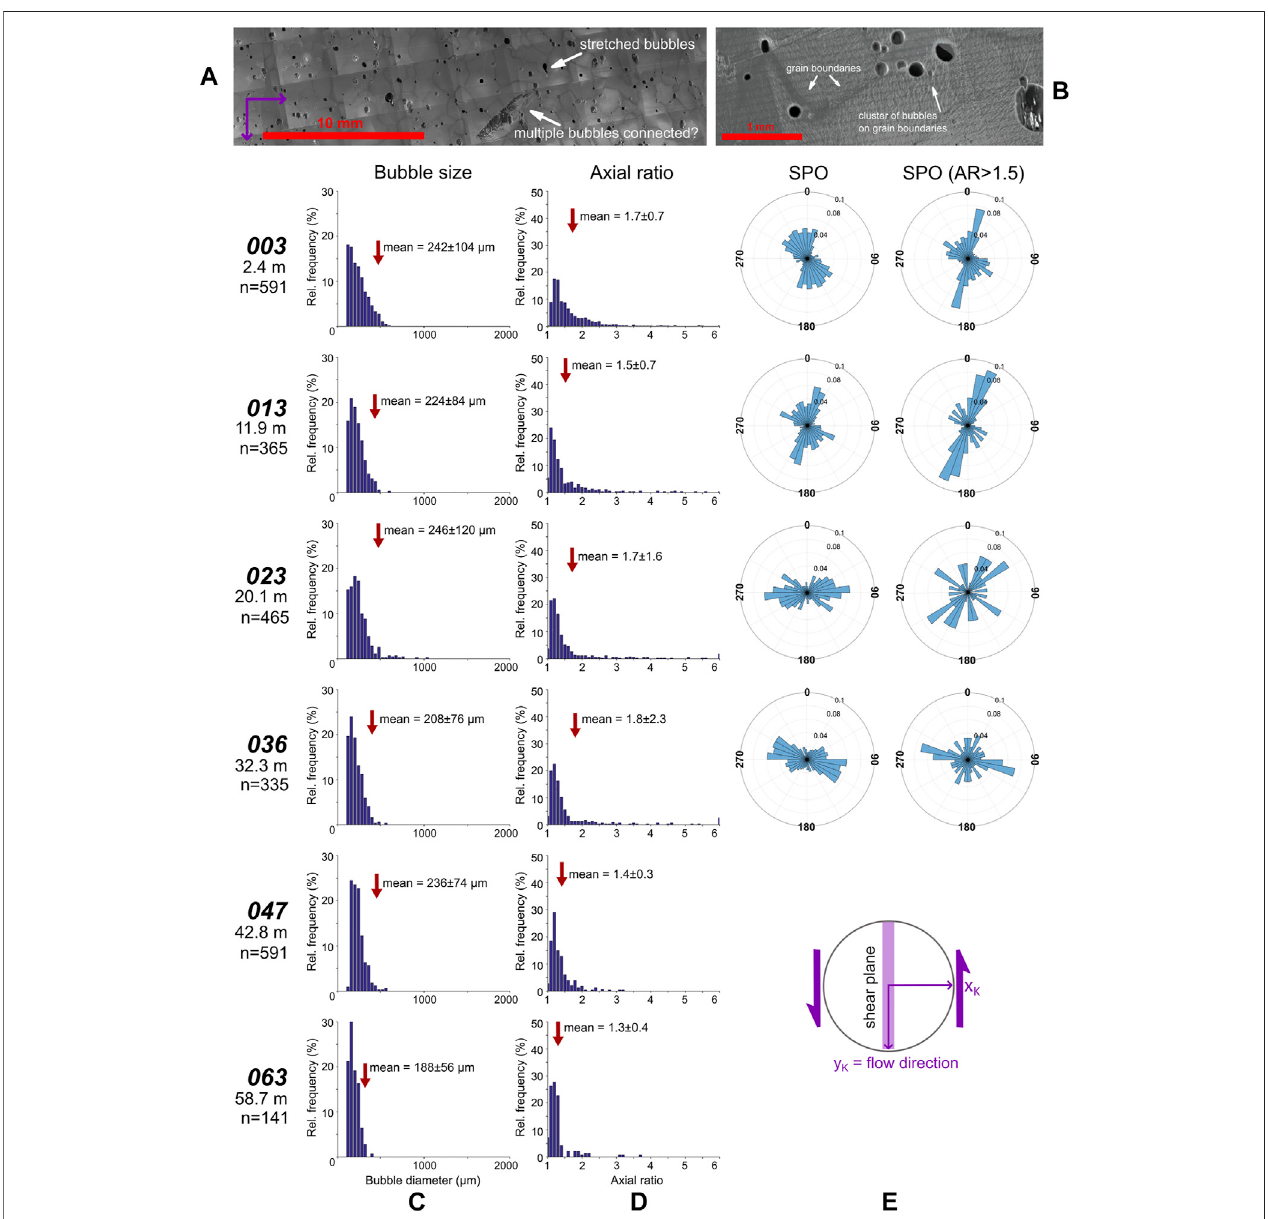
FIGURE 11 | Bubble size and shape analysis for the Priestley Glacier ice core. (A) Full montaged secondary electron image showing bubble arrangement. (B) A close-up secondary electron image of bubbles at grain boundaries. (C) The bubble diameter, (D) axial ratio and (E) 2D shape preferred orientations calculated for bubbles automatically identi fi ed from the electron image during particle